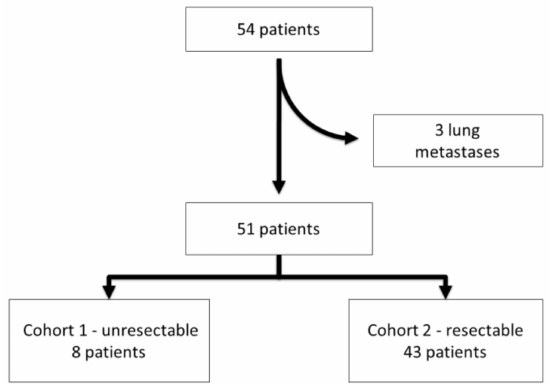
Figure 1. The flow chart of patient selection process.